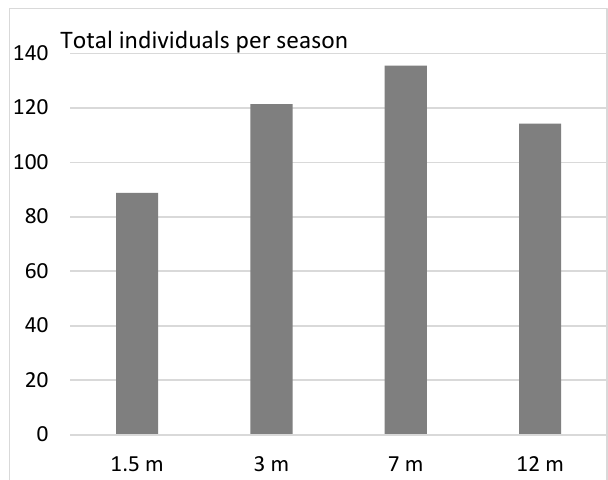
Figure 4. Cumulative abundance of Lepidoptera at various heights in pine forests.